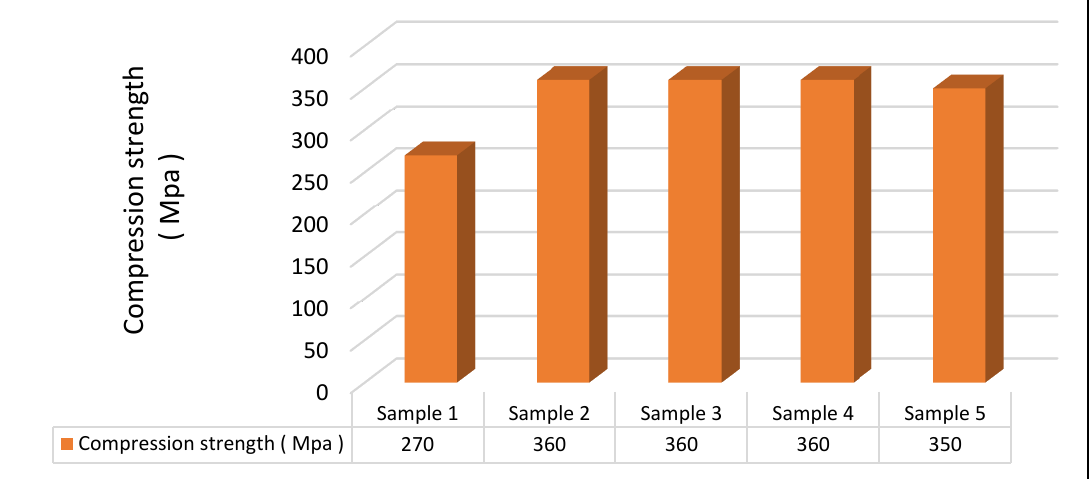
Figure 7. Compressive strength for all sintered samples.